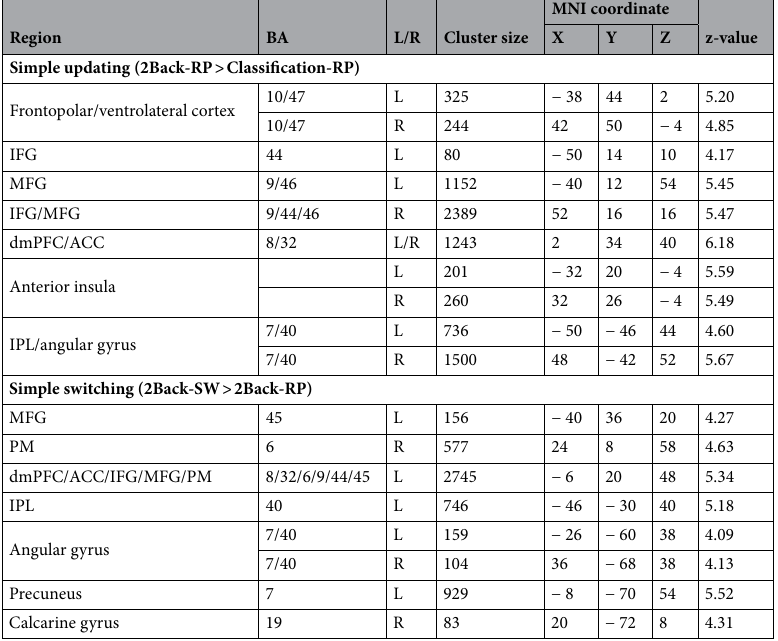
Table 2. Significant areas of activation for simple updating and switching. All z-scores listed above were found at FDR-corrected p < 0.05 with the cluster size defined at a voxel level, uncorrected p < 0.001. BA Brodmann area, L left, R right, IFG inferior frontal gyrus, MFG middle frontal gyrus, dmPFC dorsomedial prefrontal cortex, ACC anterior cingulate cortex, PM premotor cortex, IPL inferior parietal lobule, RP repeat, SW updating